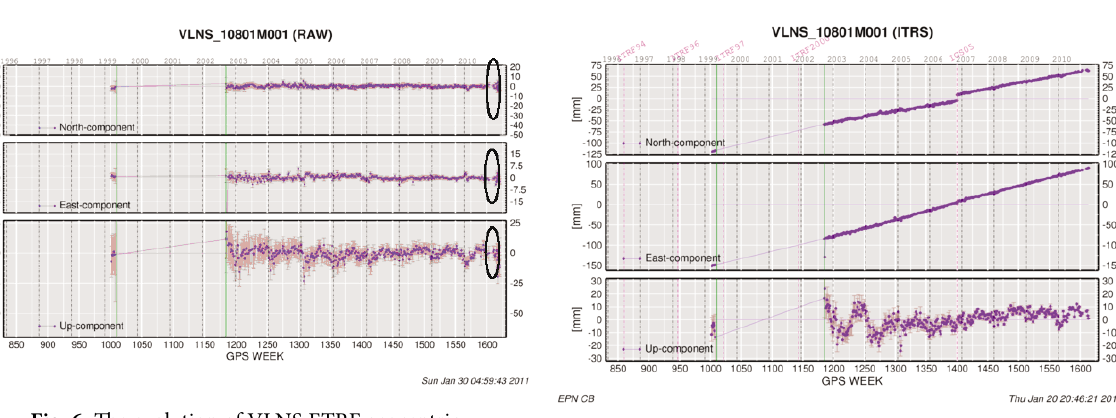
Fig. 6. The evolution of VLNS ETRF geocentric Fig. 8. The evolution of VLNS ITRF geocentric coordinates coordinates considering three components: north-south, considering three components: north-south, east-west and up east-west and up (ellipses show the data gap in 2010) (EUREF… 2011)